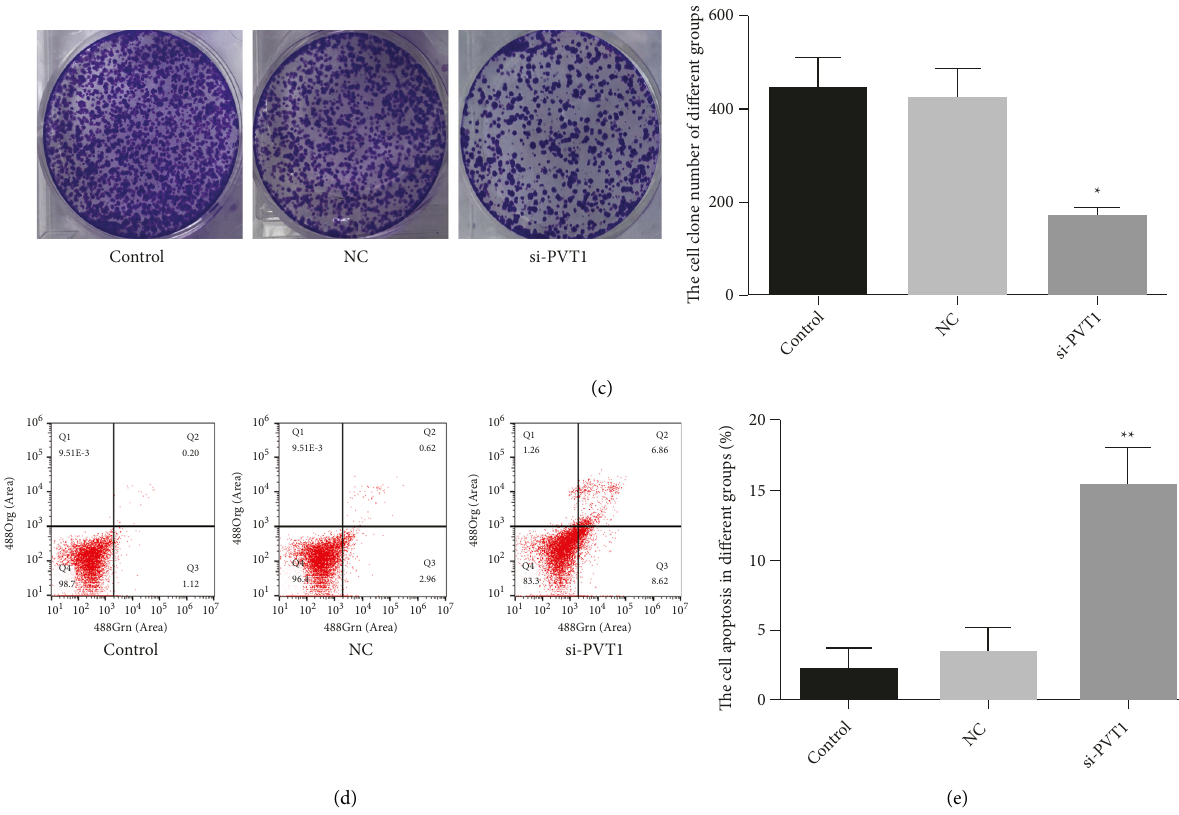
Figure 2: Knockdown of PVT1 inhibits tumor cell proliferation and promotes apoptosis of MKN-45 cells in vitro. (a) Transfection efficiency detected by RT-qPCR, showing that si-PVT1-1748 led to more effective inhibition compared to the other siRNAs. (b) The cell proliferation determined by CCK-8 assay, showing that knockdown of PVT1 inhibits tumor cell proliferation. (c) The cell proliferation of different groups analyzed by colony formation assay, showing that knockdown of PVT1 inhibits tumor cell proliferation. (d, e) The cell apoptotic rate of different groups determined by flow cytometry, showing that knockdown of PVT1 promotes tumor cell